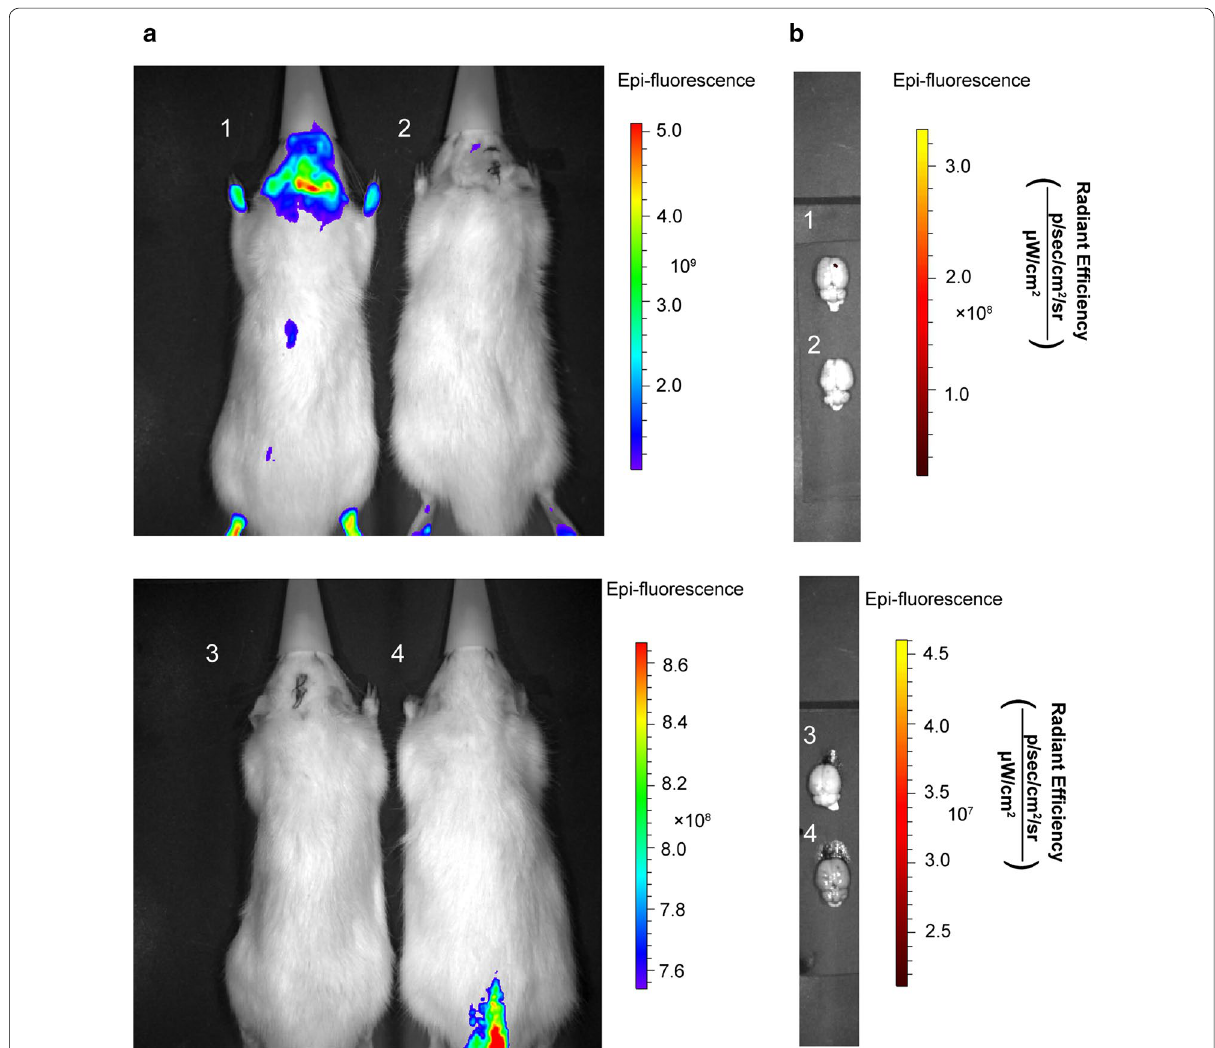
Fig. 6 a In vivo fluorescence images of glioma-bearing mice intravenously receiving different protein. 1-rat with C6 glioma cells was injected with scFab-ANG; 2-rat with C6 glioma cells was injected with scFab; 3-rat with C6 glioma tumor was injected with saline; 4-rat without C6 glioma cells was injected with scFab-ANG via the tail vein. b Ex vivo fluorescence images of